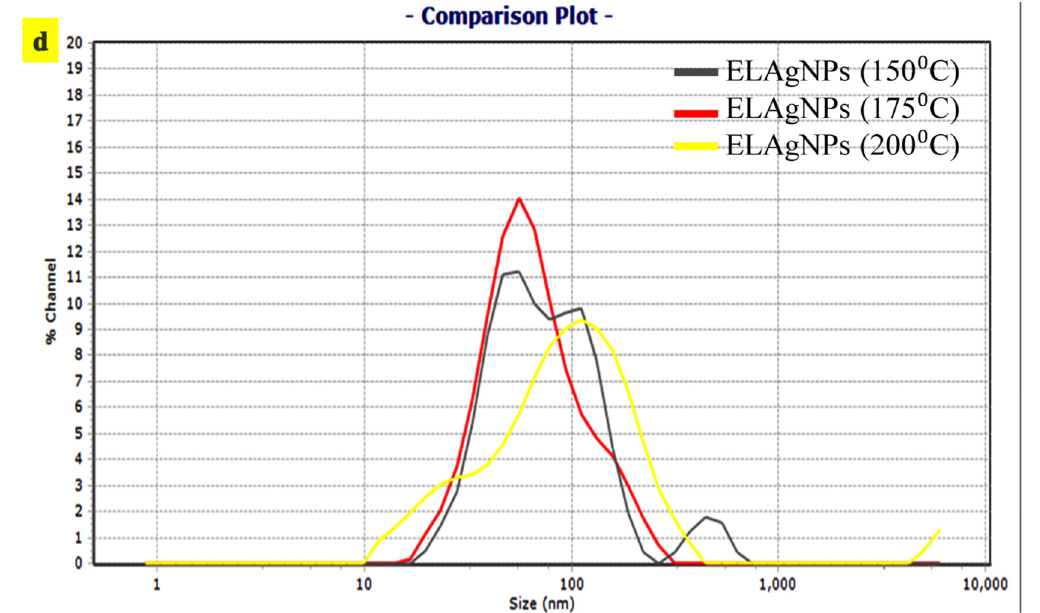
Figure 2. Particle size distribution of aqueous leaf extract of E. ferox -based AgNPs (ELAgNPs) ( a ) at 150 °C, ( b ) at 175 °C, and ( c ) at 200 °C. ( d ) Comparison plot of average hydrodynamic diameter (nm) of ELAgNPs synthesized at different temperatures on a stirrer.